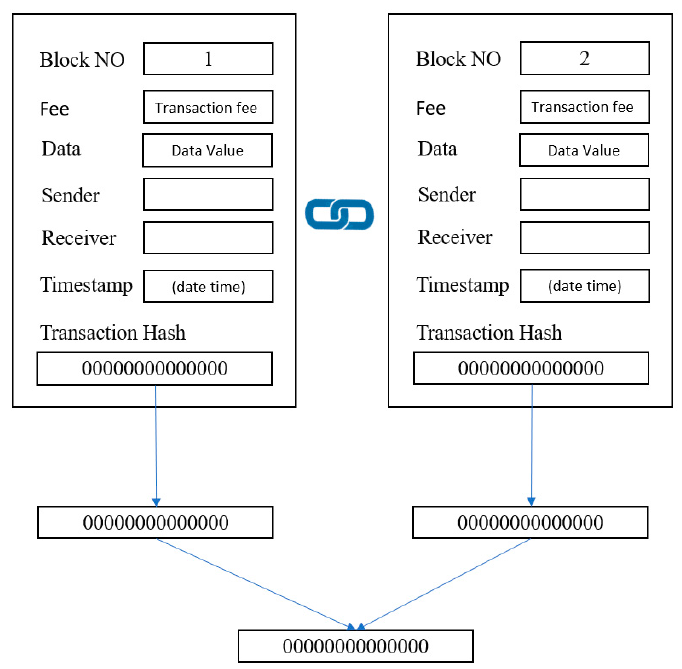
Figure 4. Blocks Figure 4. Blocks structure.